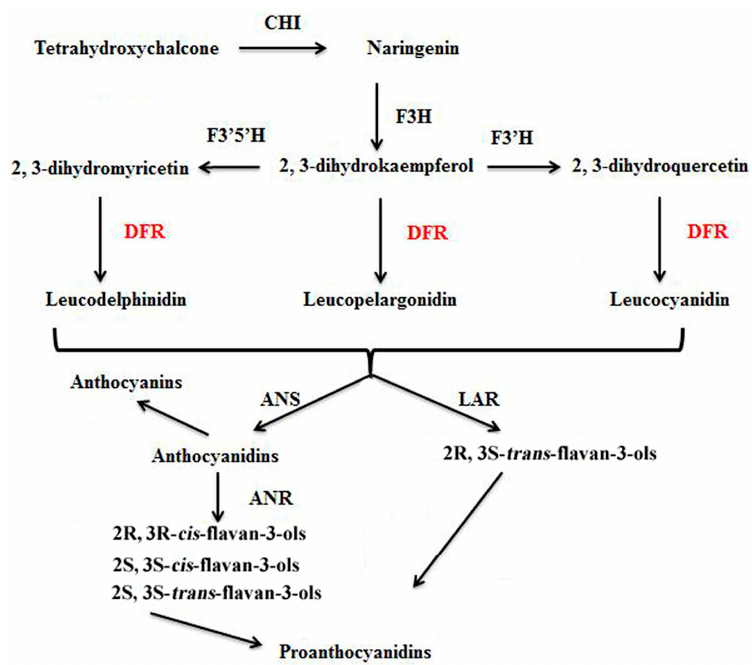
Figure 1. Biosynthetic relationship of DFR to anthocyanins, flavan-3-ols, and proanthocyanidins. CHI: chalcone isomerase; F3H: (2S)-flavanone 3-hydroxylase; F3 ′ H: flavonoid 3 ′ -hydroxylase; F3 ′ ,5 ′ H: flavonoid 3 ′ ,5 ′ -hydroxylase; DFR: dihydroflavonolreductase; ANS: anthocyanidin synthase (also known as leucoanthocyanidin dioxygenase); LAR: leucoanthocyanidin reductase; ANR: anthocyanidin